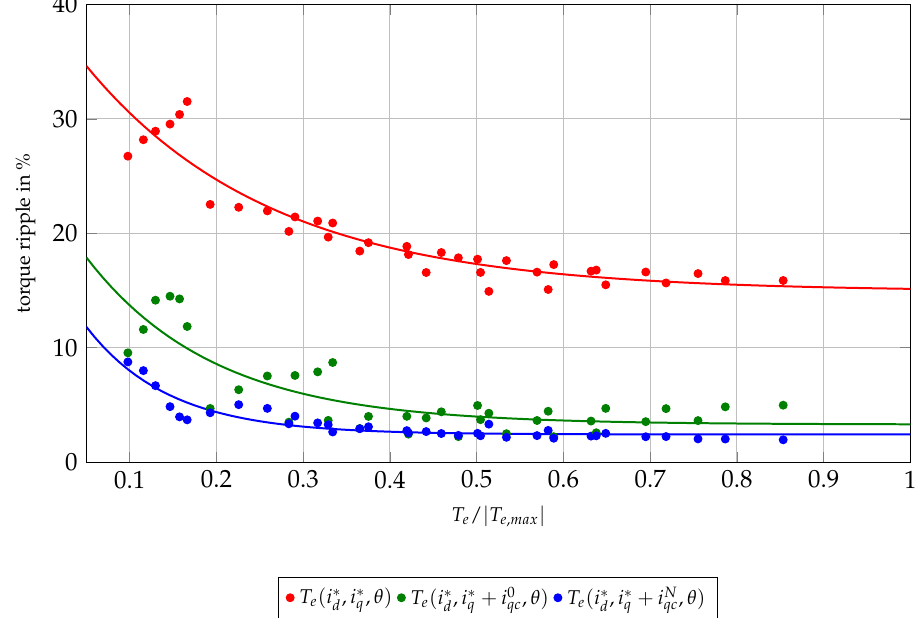
Figure 6. Averaged torque ripple relative to the respective mean torque without compensation, with compensation by i 0 qc and by i N qc